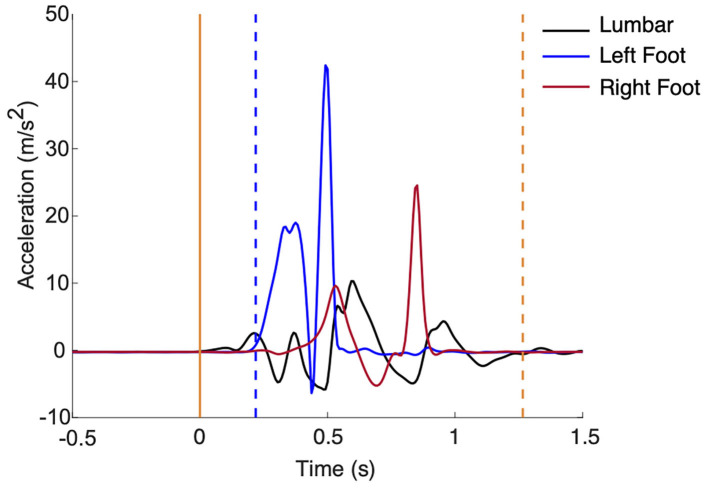
(Left) Support was released at time 0 (solid yellow). Step latency (blue dashed line) and time to stabilization (yellow dashed line) are marked.